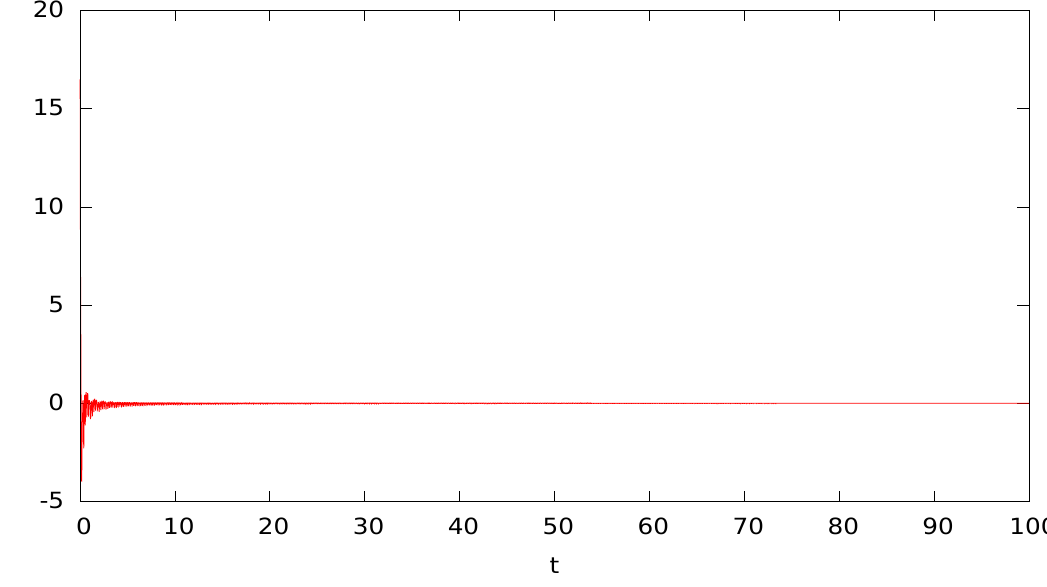
Figure 3. The graph of the change in time of the Lyapunov exponent LE 1